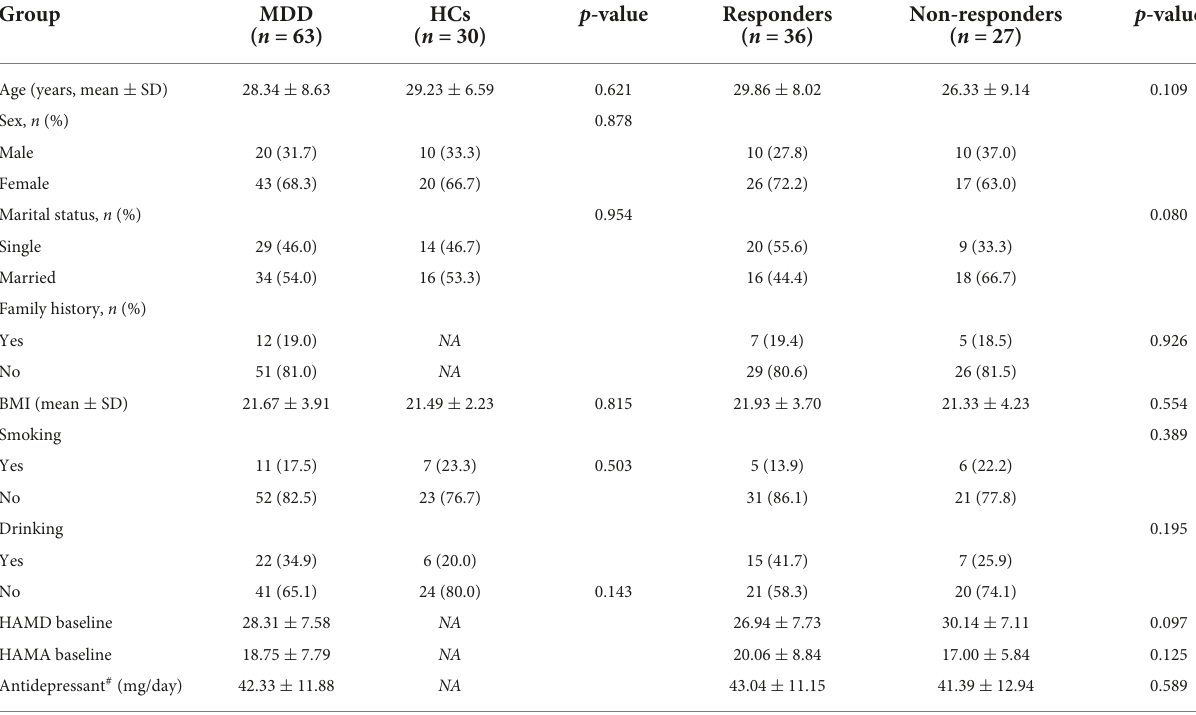
TABLE 1 Comparison of clinical and demographic characteristics between patients with MDD and HCs, responders, and non-responders. Group MDD